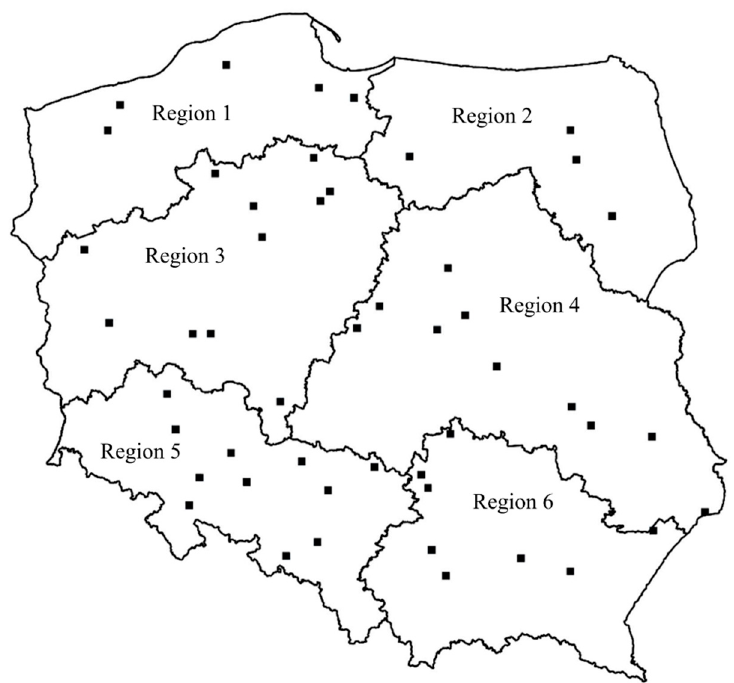
Figure 1. The 49 locations used to generate multi-environmental trial datasets across the six agro-ecological regions in Poland.